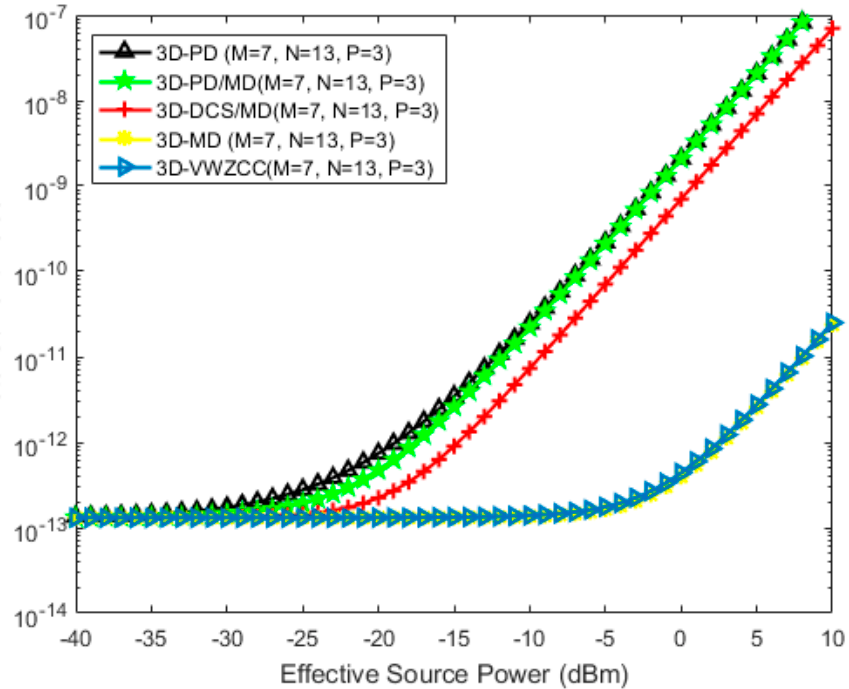
Figure 9. Photo current noise against effective source power when the number of simultaneous users K = 250 and data rate R b = 1.25 Gbps.